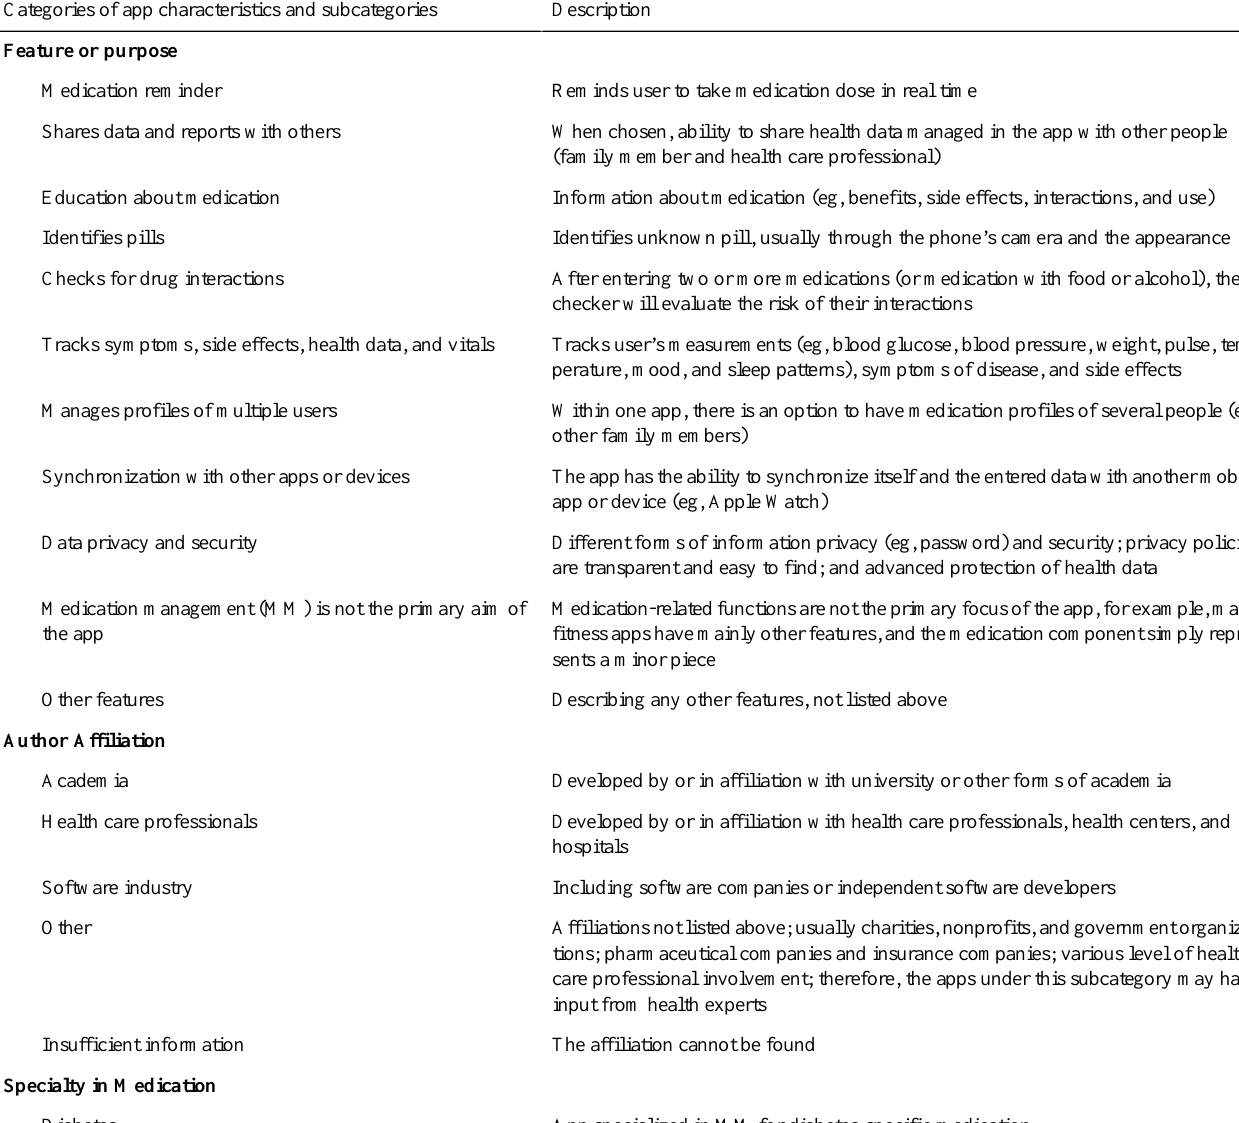
Table 2. Final framework for app characteristics categorization, including description for selected subcategories. DescriptionCategories of app characteristics and